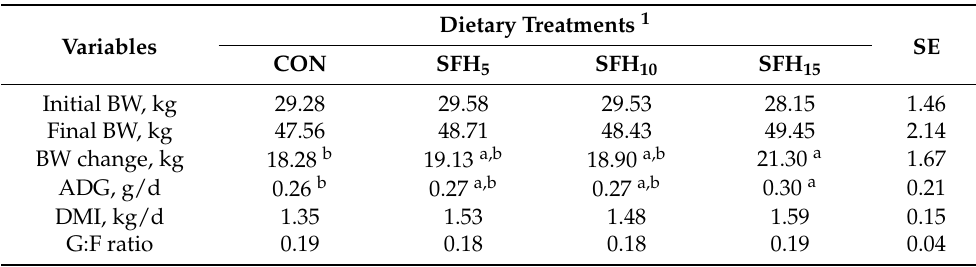
Table 2. Productive performance of growing Awassi lambs fed the experimental diets containing different levels of sunflower hulls.